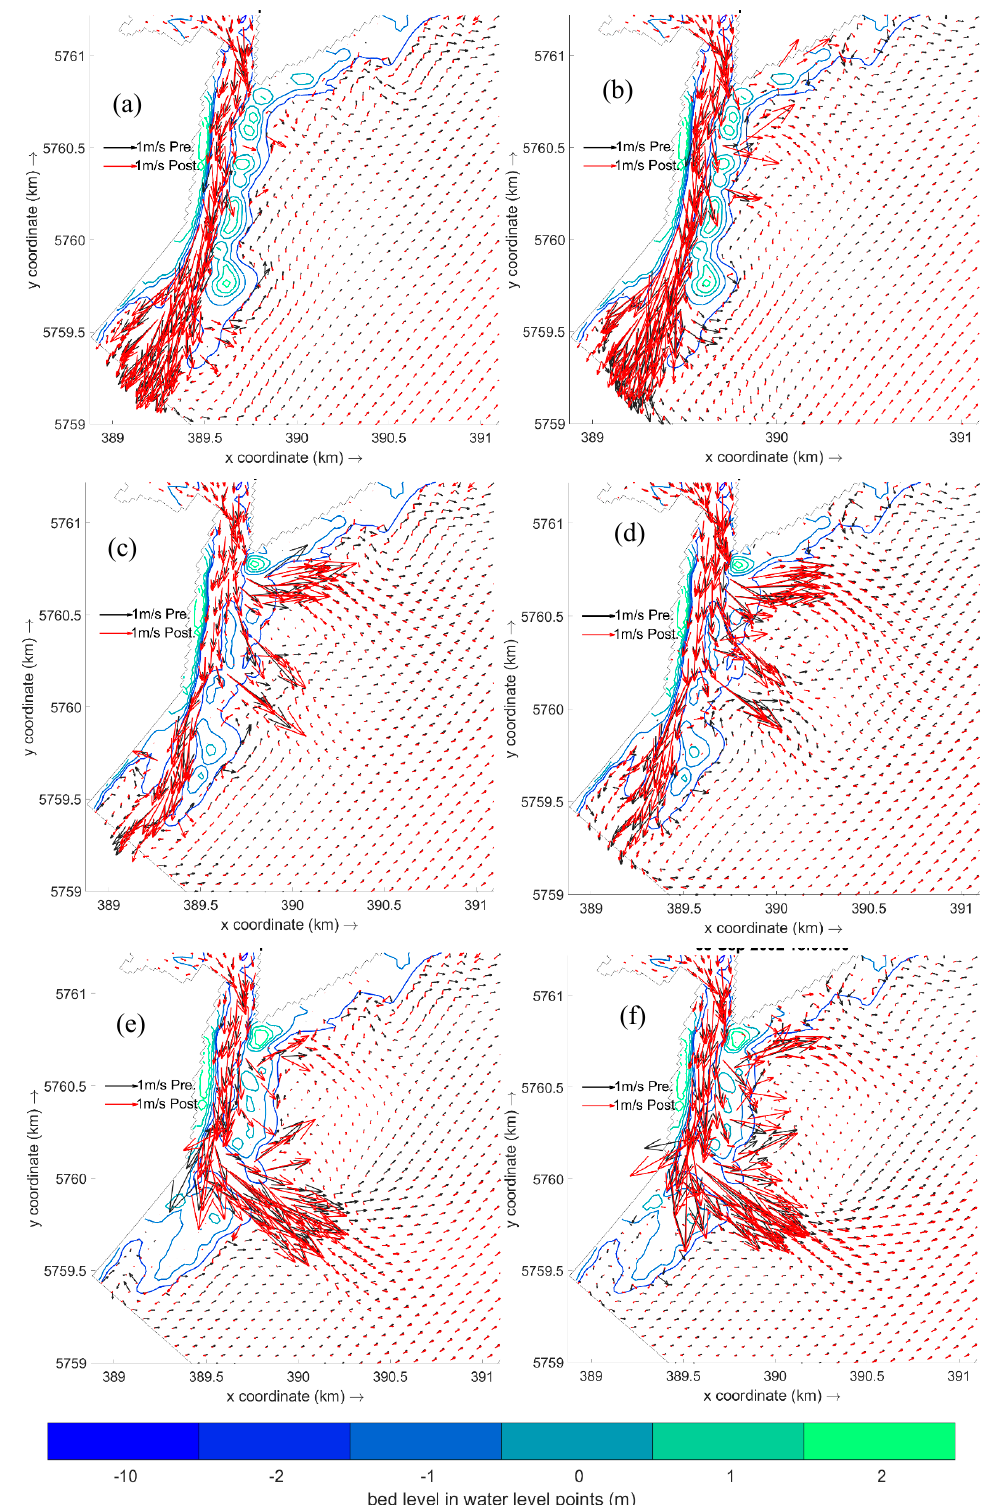
Figure 16. The comparisons of maximum ebb currents between pre-storm (black arrows) and post-storm (red arrows) in every scenario: ( a ): ‘present’ scenario for State A; ( b ): ‘future’ scenario for State A; ( c ): ‘present’ scenario for State B; ( d ): ‘future’ scenario for State B; ( e ): ‘present’ scenario for State C; ( f ): ‘future’ scenario for State C. The color bar stands for the depths and the counter line shows the bathymetry of shoal